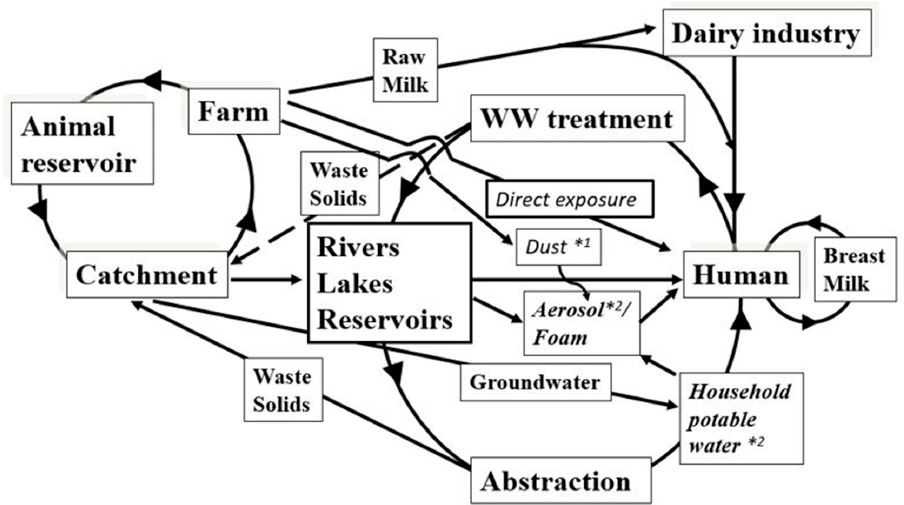
Figure 4. Revised model Map transmission and human exposure based on Pickup et al. [41] accounting for additional routes via potable water, natural foam and aerosols. * 1 [63] * 2 [44].